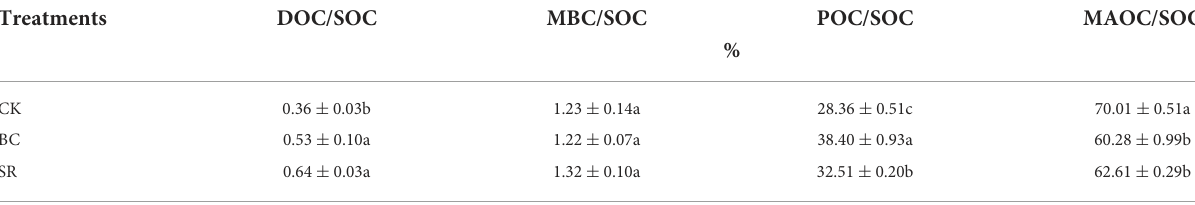
TABLE 2 The proportions of different SOC fractions accounting for SOC contents.